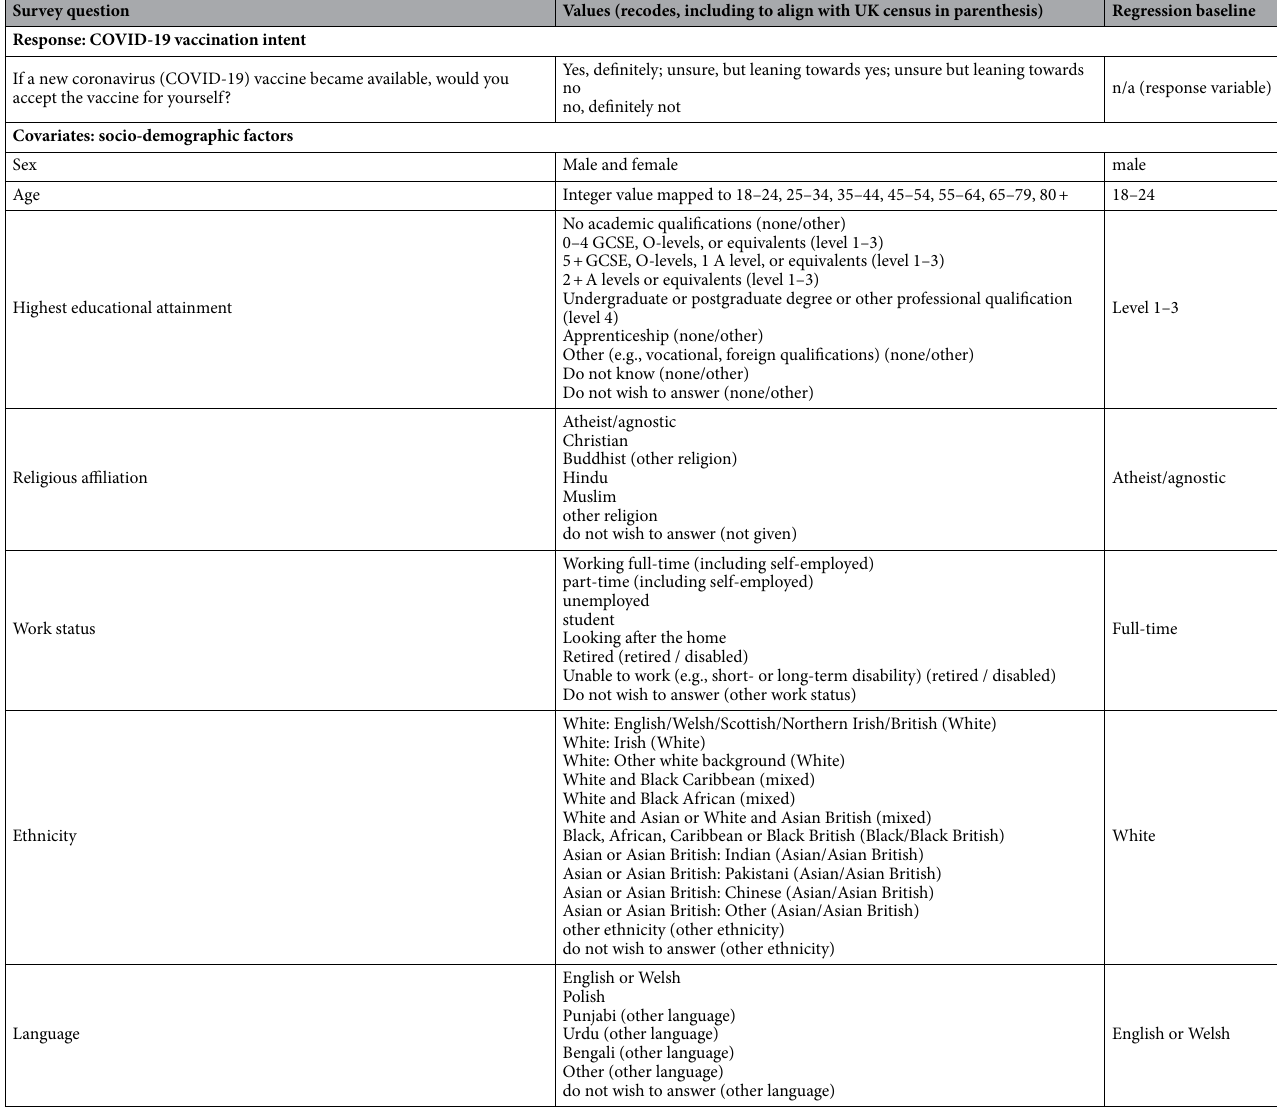
Table 1. Study data Survey items are shown with possible responses (including recodes, if any), and baselines used in the ordinal multilevel logistic regressions. COVID-19 vaccination intent is the study response